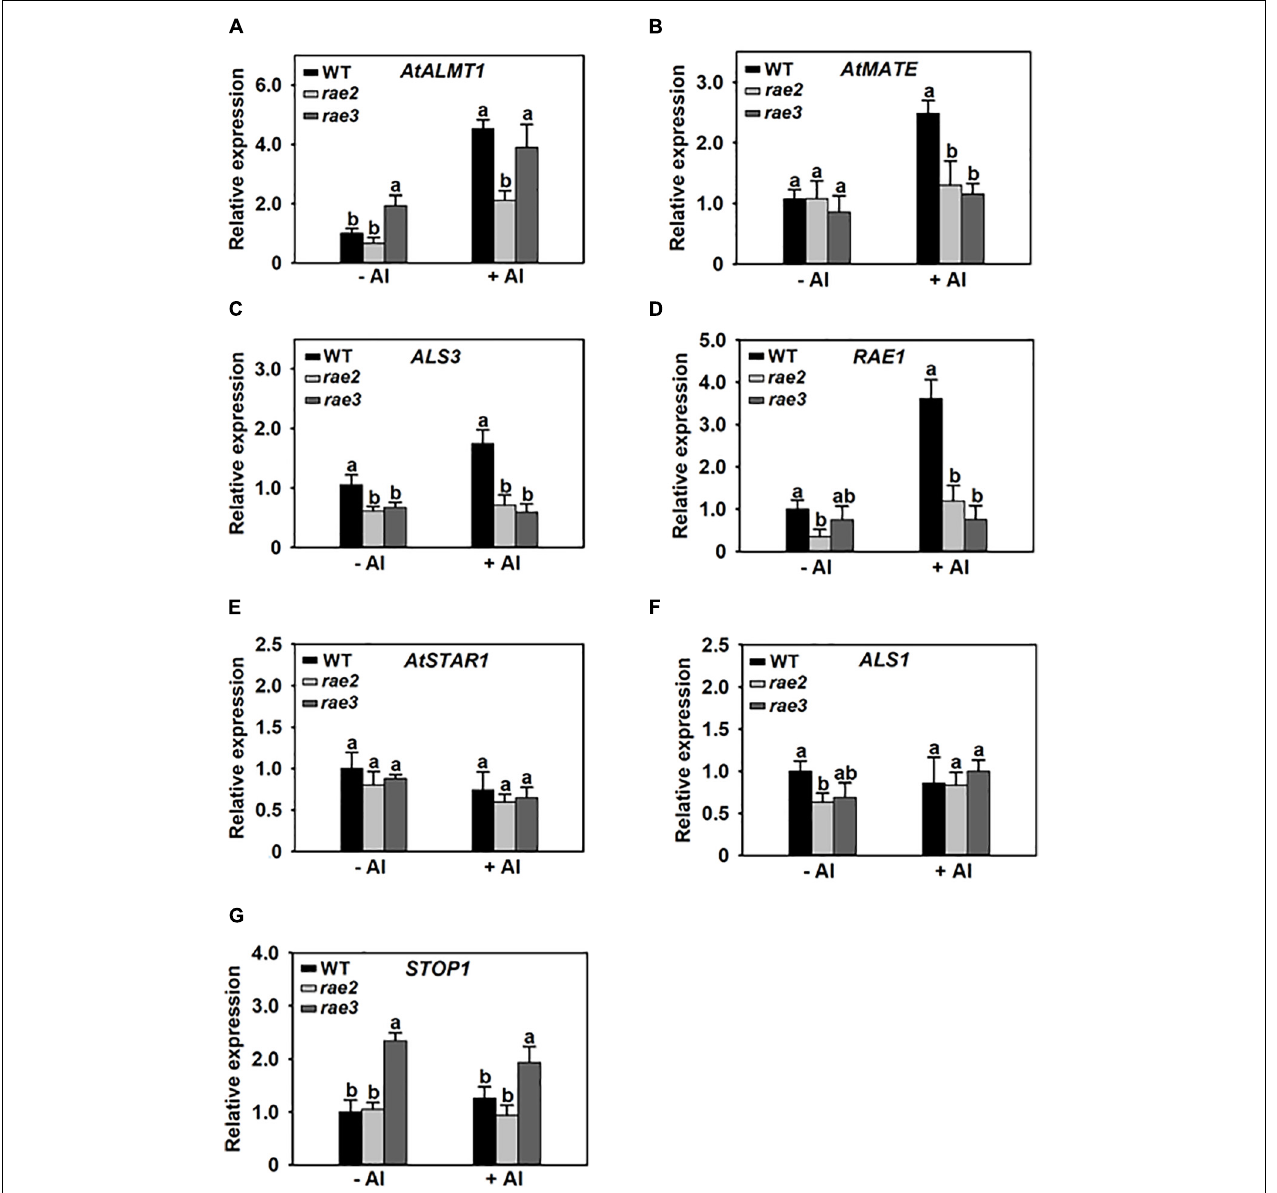
FIGURE 6 | The rae2 mutation does not influence STOP1 mRNA export. Three-week-old plants of WT, rae2, and rae3 were treated with 0 (–Al) or 30 µ M Al (+Al) for 12 h, and then the root nuclei were isolated for the real-time RT-PCR analysis of Al-resistance genes, which include AtALMT1 (A) , AtMATE (B) , ALS3 (C) , RAE1 (D) , AtSTAR1 (E) , ALS1 (F) , and STOP1 (G) . Values are means ± SD ( n = 3). Means with different letters are significantly different ( P < 0.05, ANOVA followed by Tukey’s